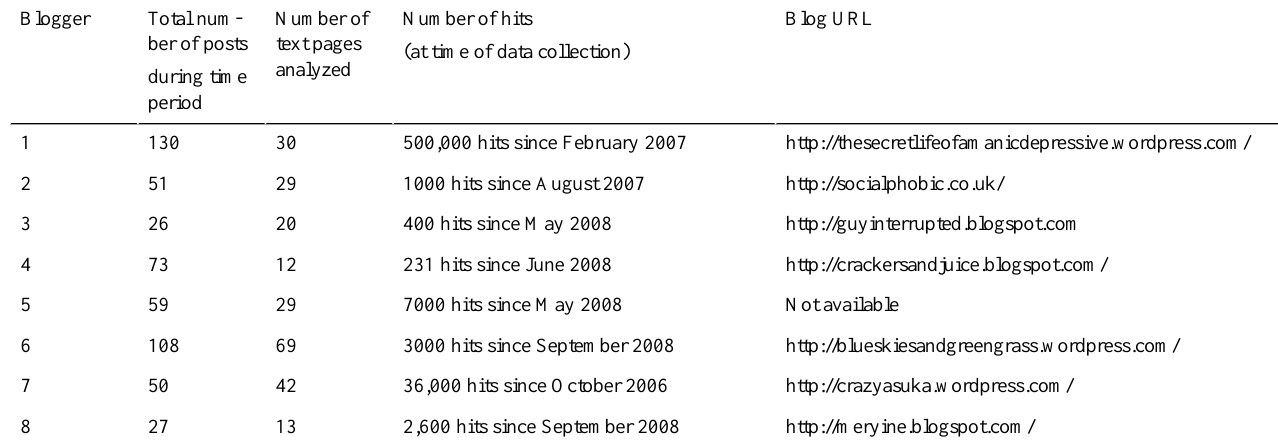
Table 2. Characteristics of